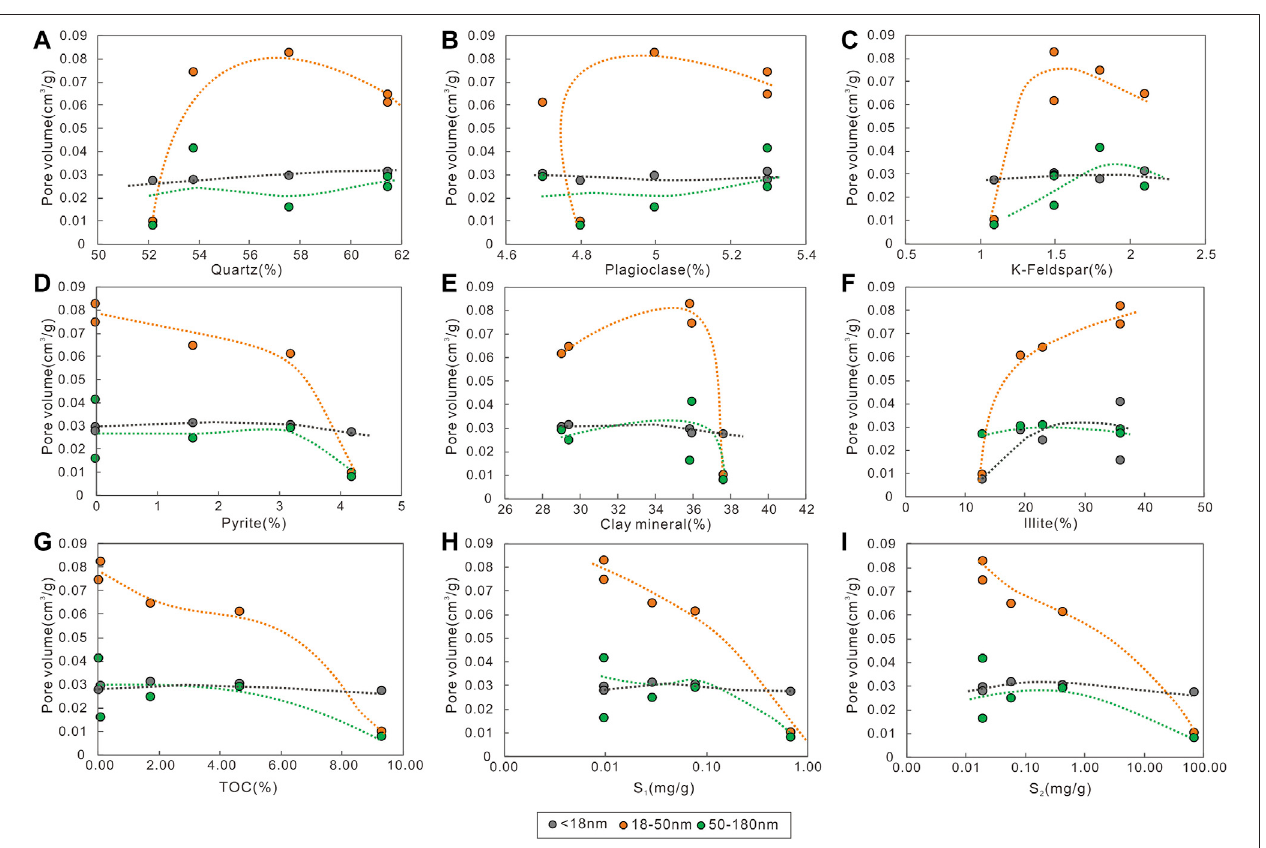
FIGURE11| Relationshipbetweenmineralcontentsandporevolumes. (A) -quartzvsporevolume, (B) -plagioclasevsporevolume, (C) -k-feldsparvsporevolume, (D) -pyrite vs pore volume, E-clay minerals vs pore volume, F-illite vs pore volume, G-TOC vs pore volume,H-S 1 vs pore volume, I-S 2 vs pore volume.